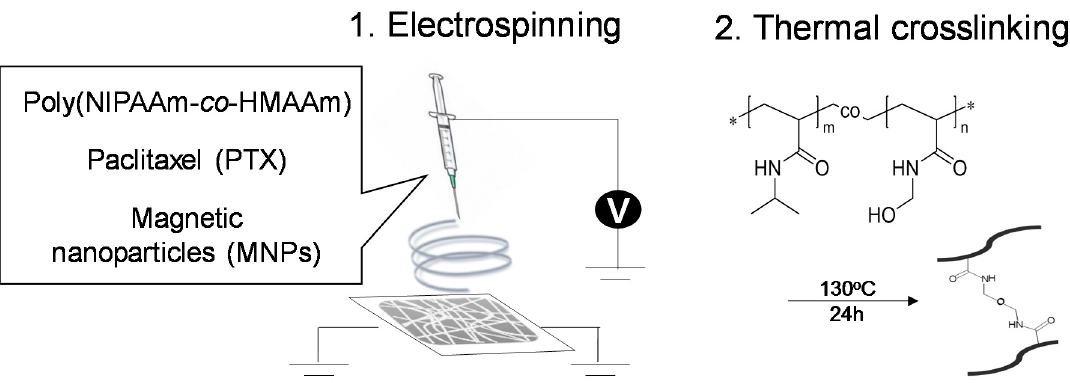
Figure 2. Fabrication of thermally-crosslinkable temperature-responsive fiber mesh by electrospinning and thermal curing processes by self-condensation.